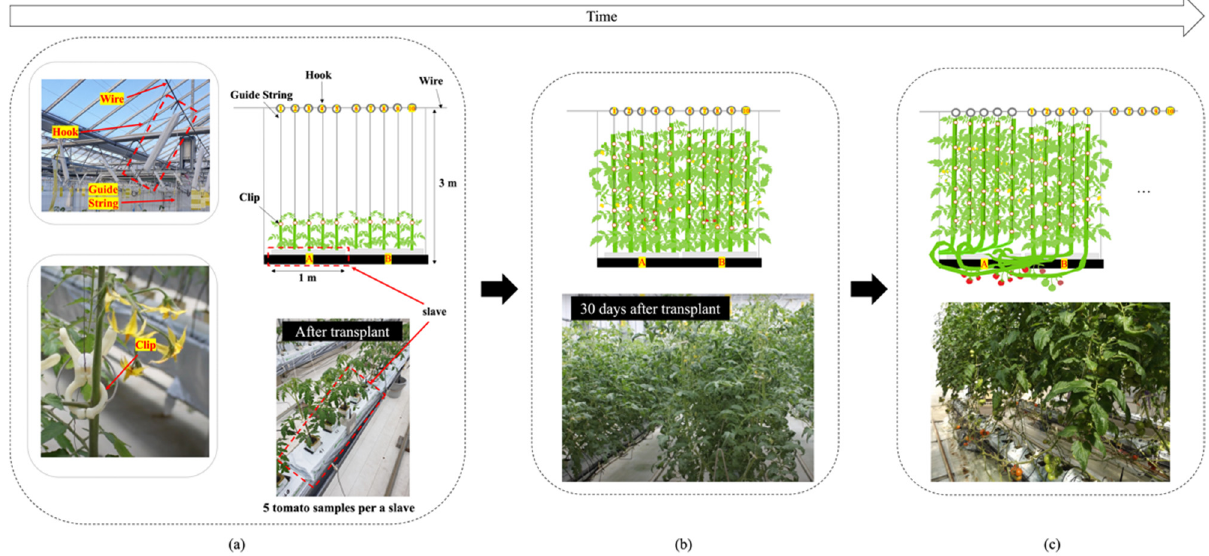
Figure 3. Complexity of tomato structure over time. ( a ) low complexity of tomato structure; ( b ) high complexity of tomato structure to track specific flowers, fruit, and ripe tomato samples because the number of invisible tomato flowers and fruit increased; ( c ) highest complexity of tomato structure because the hooks are moved in irregular positions and directions.